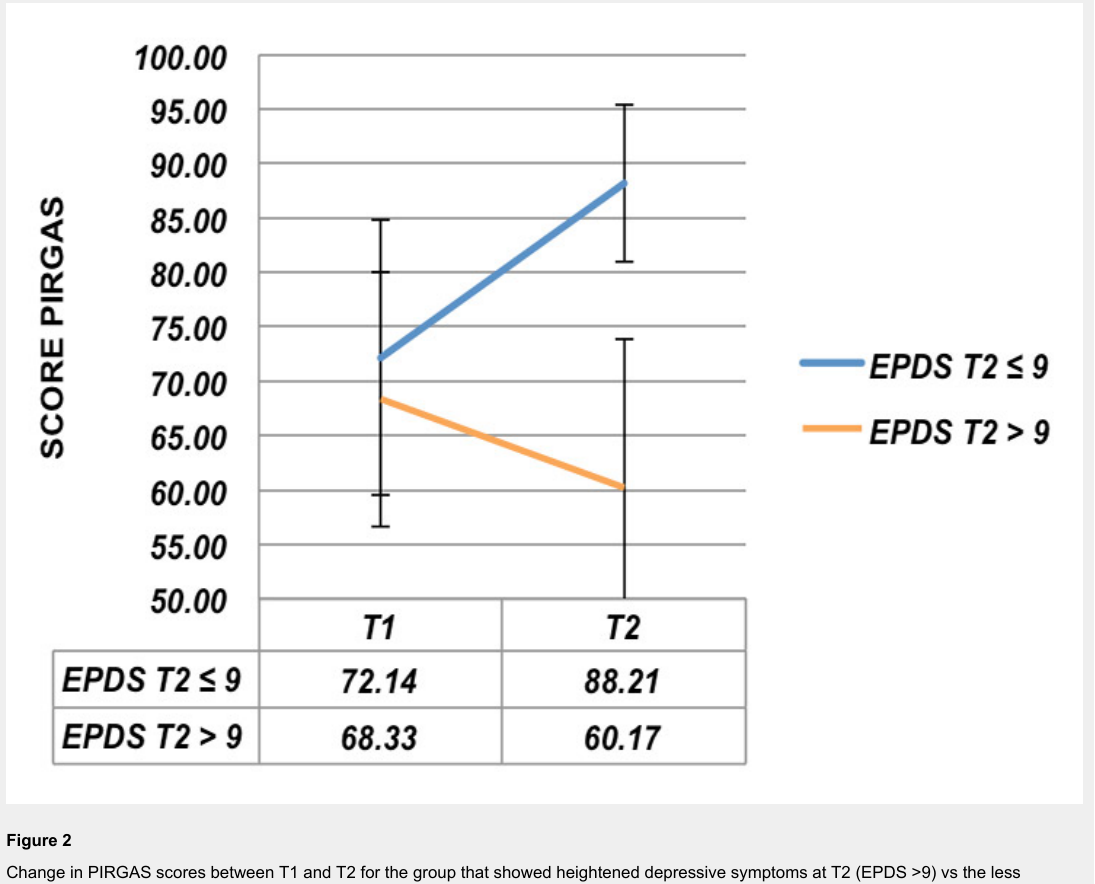
Figure 2 Change in PIRGAS scores between T1 and T2 for the group that showed heightened depressive symptoms at T2 (EPDS >9) vs the less depressed group (EPDS ≤9). Error bars depict standard deviation.